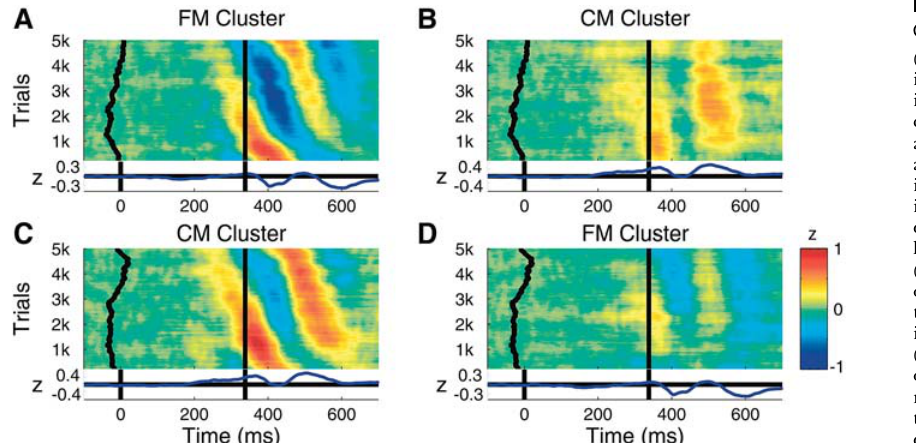
0.3) between the two clusters in the postresponse time/frequency window. Note the induced (top-down, left-to-right) slope of the latency of the two (orange) positive-going CM cluster theta wave fronts. (C) Phase-sorted ERP image, as in (A), of the normalized CM cluster trials. (D) FM cluster component trials sorted in the same trial order as (C). Again, the partial theta-band phase coherence of the two clusters in the postresponse period is reflected in the diagonal (blue) negative-going wave fronts of the FM cluster data. DOI: